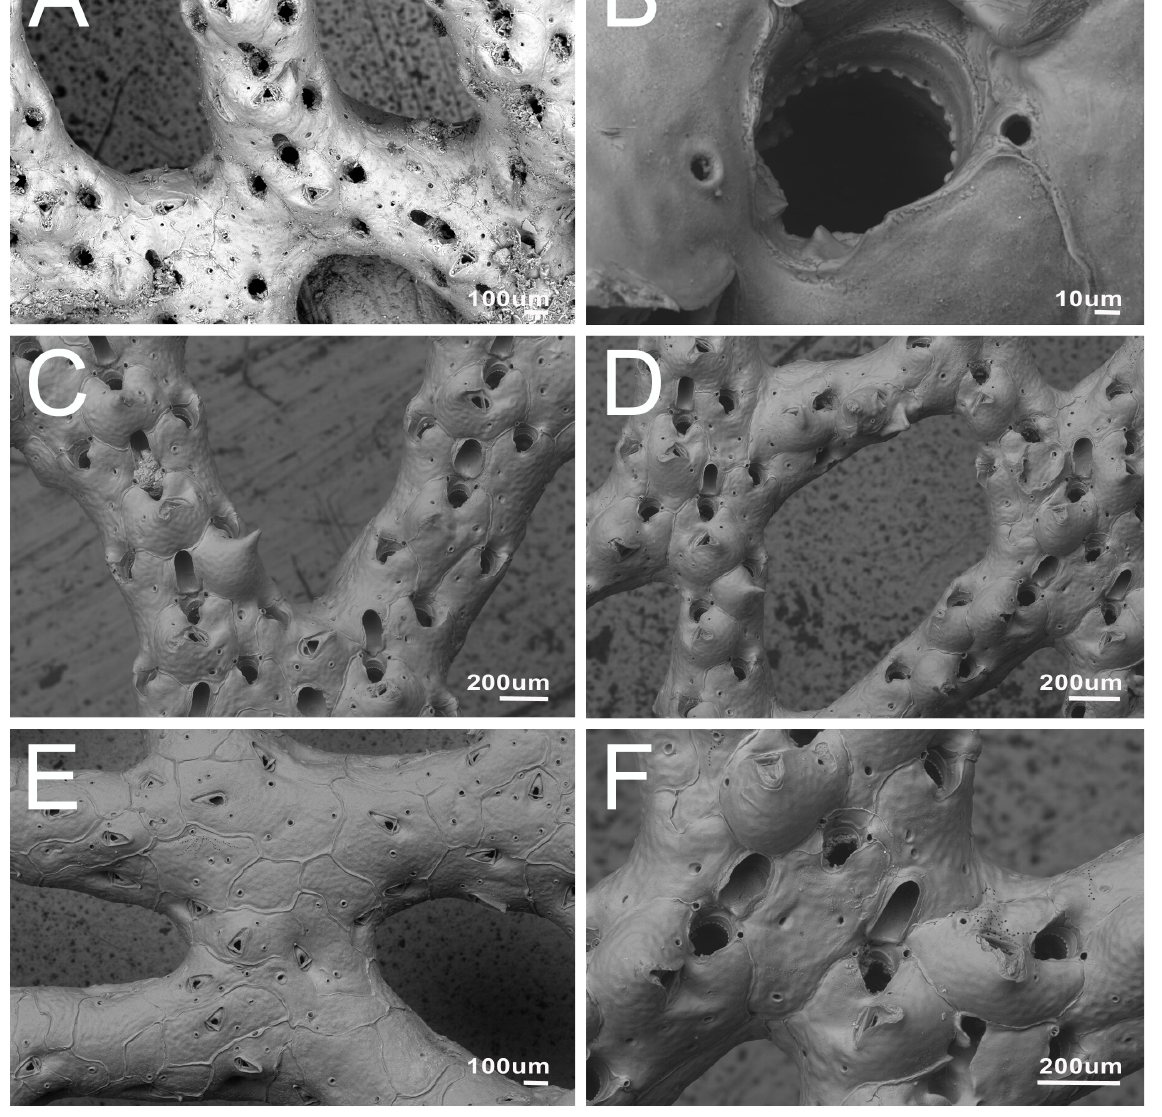
Fig. 8. Schizoretepora imperati (Busk, 1884). A from Retepora imperati , syntype (NHMUK 1963.2.12.202); B–F from Retepora imperati , syntype (NHMUK 1934.2.16.23). A . Colony, frontal view. B . Primary orifice, detail. C–D . Ovicellated autozooids with giant avicularia. E . Detail of ovicellated autozooid with giant avicularia. F . Abfrontal view with triangular